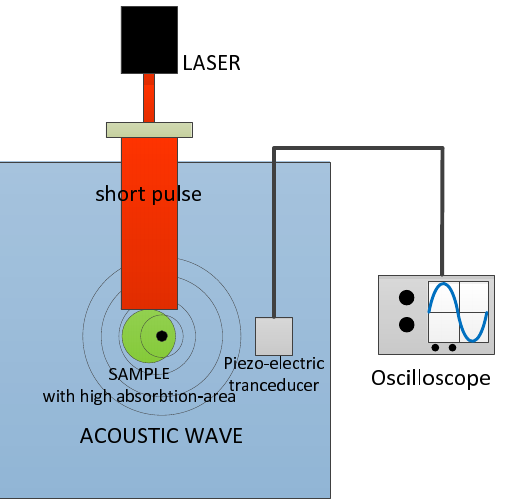
Figure 24. Schematic of a photoacoustic setup for bio-medical applications.